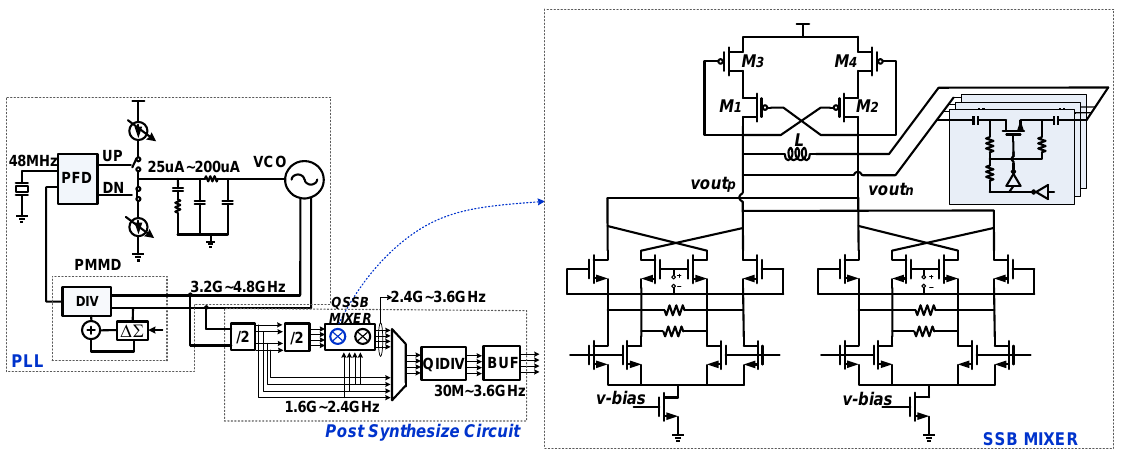
Figure 8 . The proposed frequency synthesizer (FS) and single side-band (SSB) mixer. Figure 8. The proposed frequency synthesizer (FS) and single side-band (SSB)